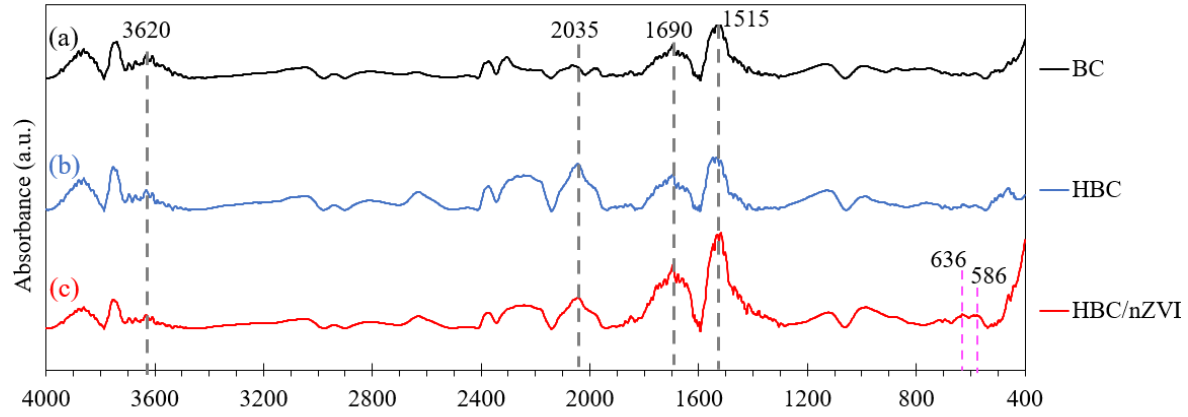
Figure 8. FTIR spectra of BC, HBC, and HBC/nZVI after reacting with Cr(VI) aqueous solutions.